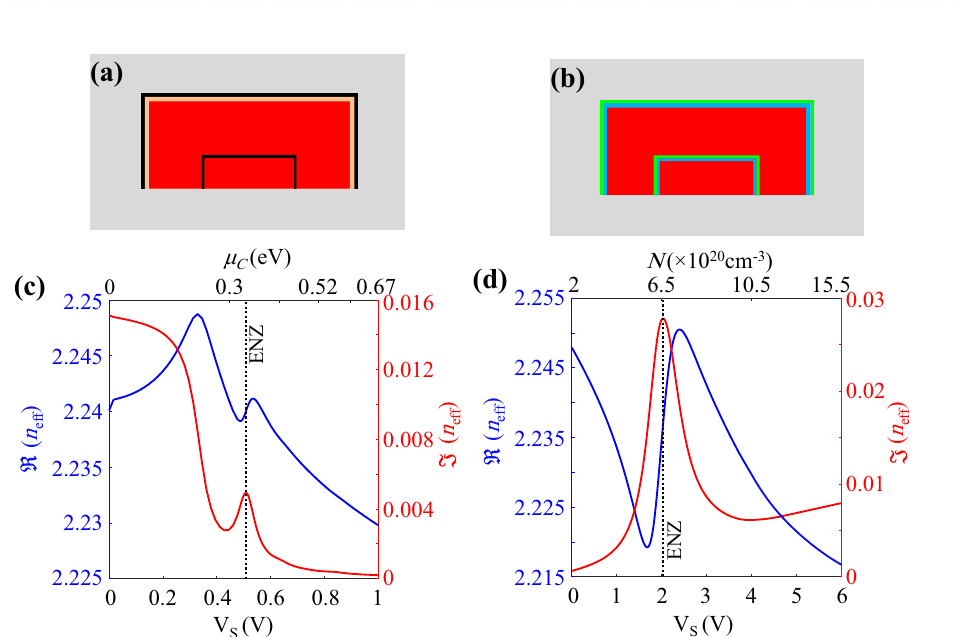
Figure 2. Cross section of the hypothetical waveguide ( a ) with a stack of cSi/graphene/aSi/hBN/graphene and without any ITO layers, and ( b ) with a stack of cSi/ HfO 2 /ITO/aSi/ HfO 2 /ITO and without graphene sheets. Variations of real and imaginary parts of the effective index for TE mode of the waveguide, ( c ) in part ( a ) versus the applied voltage and graphene chemical potential, and ( d ) in part ( b ) versus the applied voltage and ITO carrier